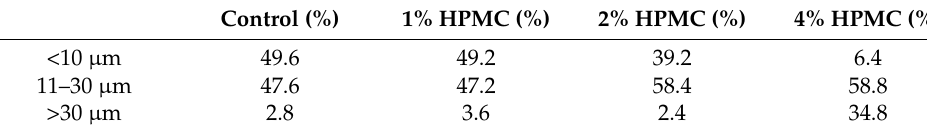
Table 3. Particle size distribution of the collapsed particles.